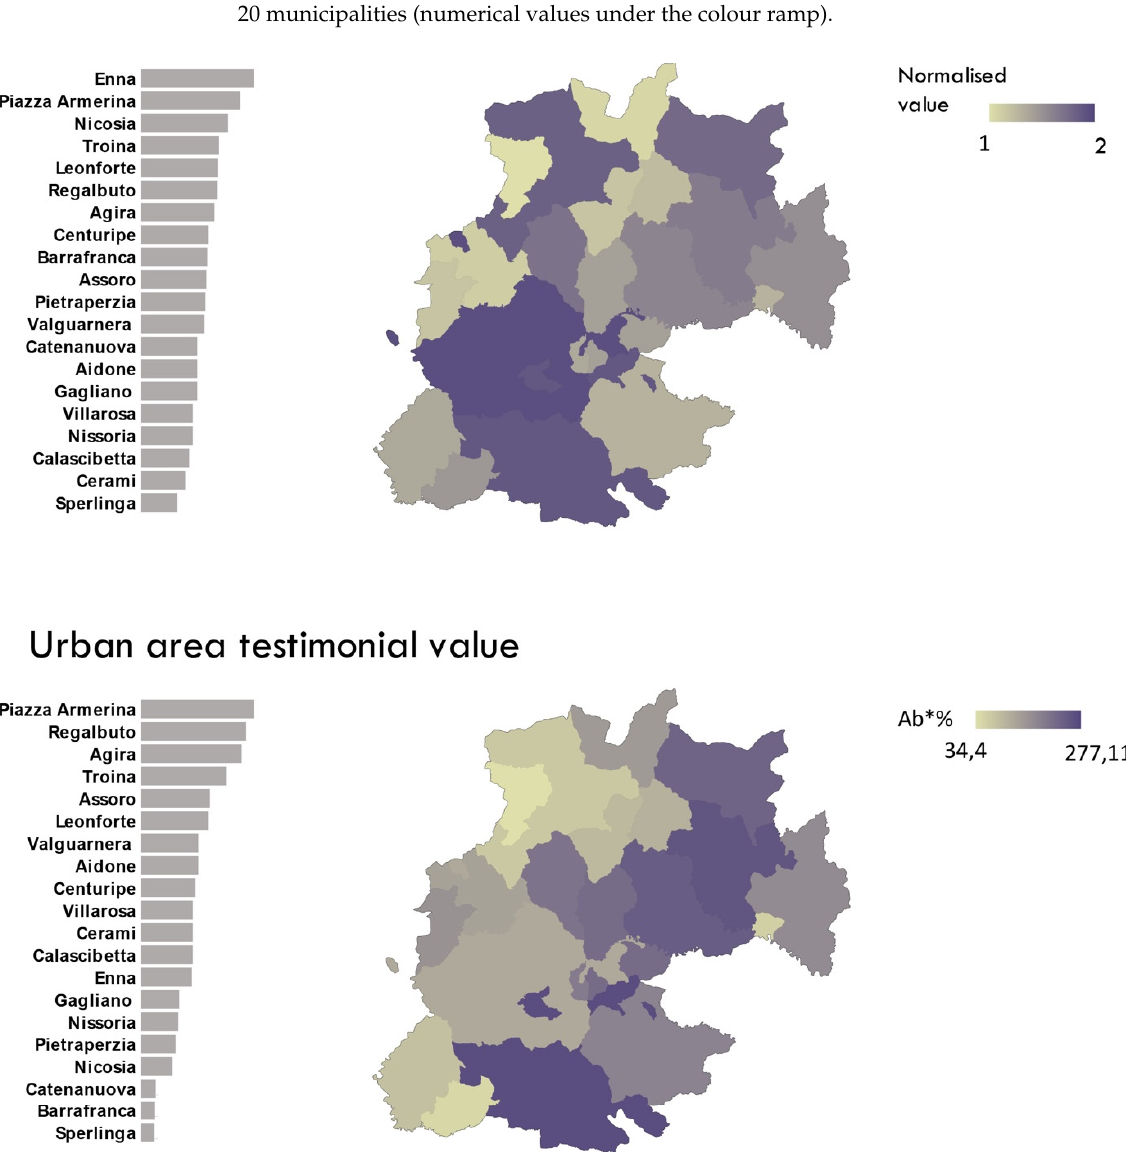
Figure 12. Maps and correlations of Economic capital and Urban area testimonial value over the 20 municipalities (numerical values under the colour ramp).